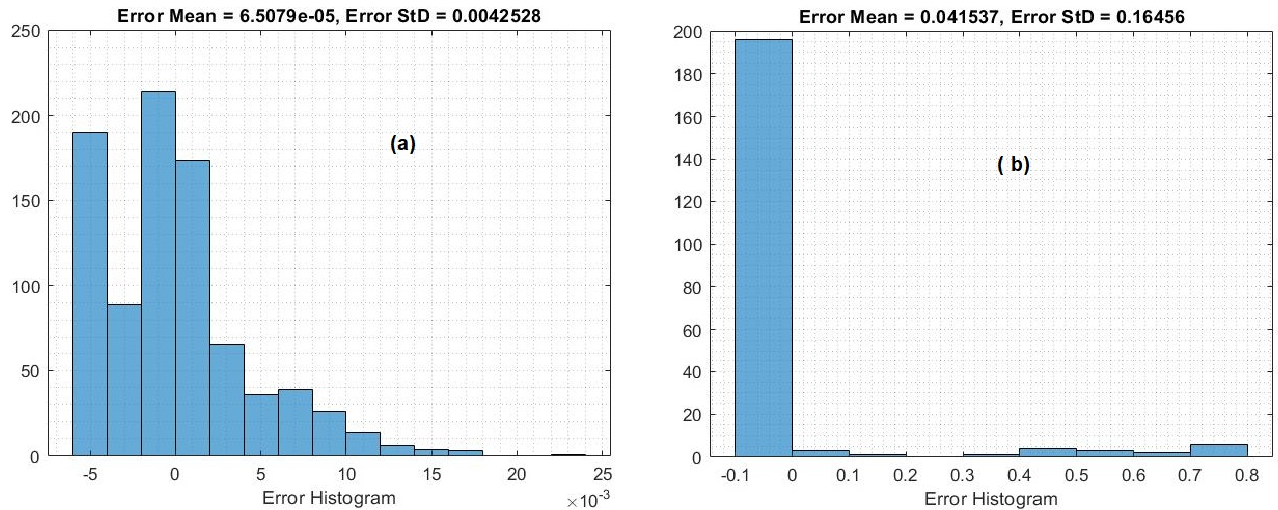
Figure 9. Error histograms of the LSTM model’s predictions of the prices of the Ethereum cryptocur- rency in ( a ) training and ( b ) testing.